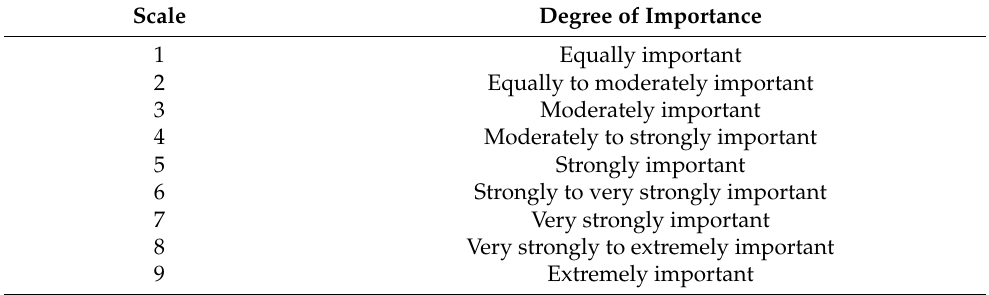
Table 4. Relative importance scale of AHP [4].